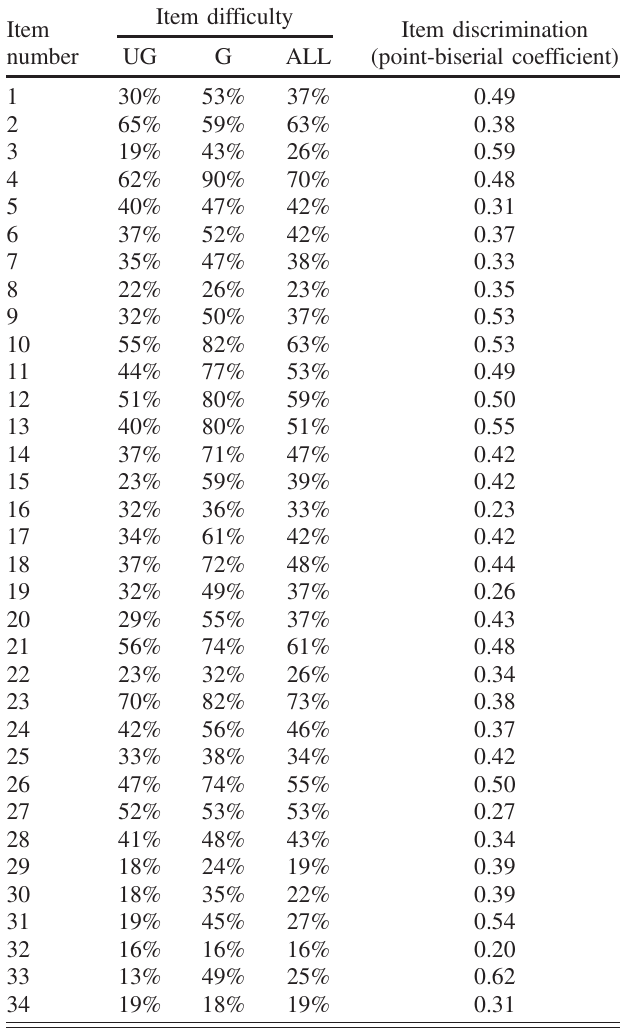
TABLE II. Item difficulty (percentage of students answering the question correctly) for undergraduate students (UG), graduate students (G), and all students combined (ALL) and item dis- crimination (point-biserial coefficient) for each item on the